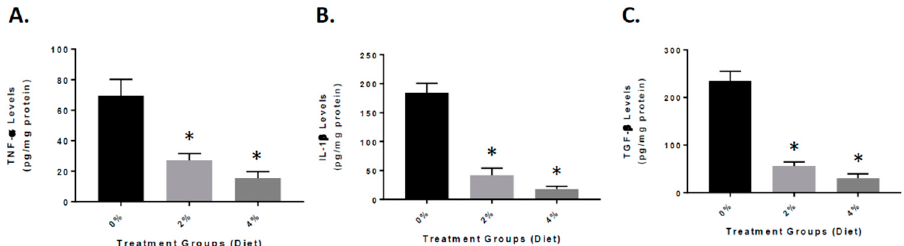
Figure 5. Reduced inflammatory markers in the brain of APP/PS-1 mice. Mice were treated with vehicle (Vehicle), or GF diets for 4 months at 2% or 4%. Quantitative analysis of TNF- α ( A ), IL-1 β ( B ), and TGF- β ( C ) in the APP/PS-1 brains was determined by enzyme-linked immunosorbent assay (ELISA). n = 20 per group. * p < 0.01 (compared with vehicle).